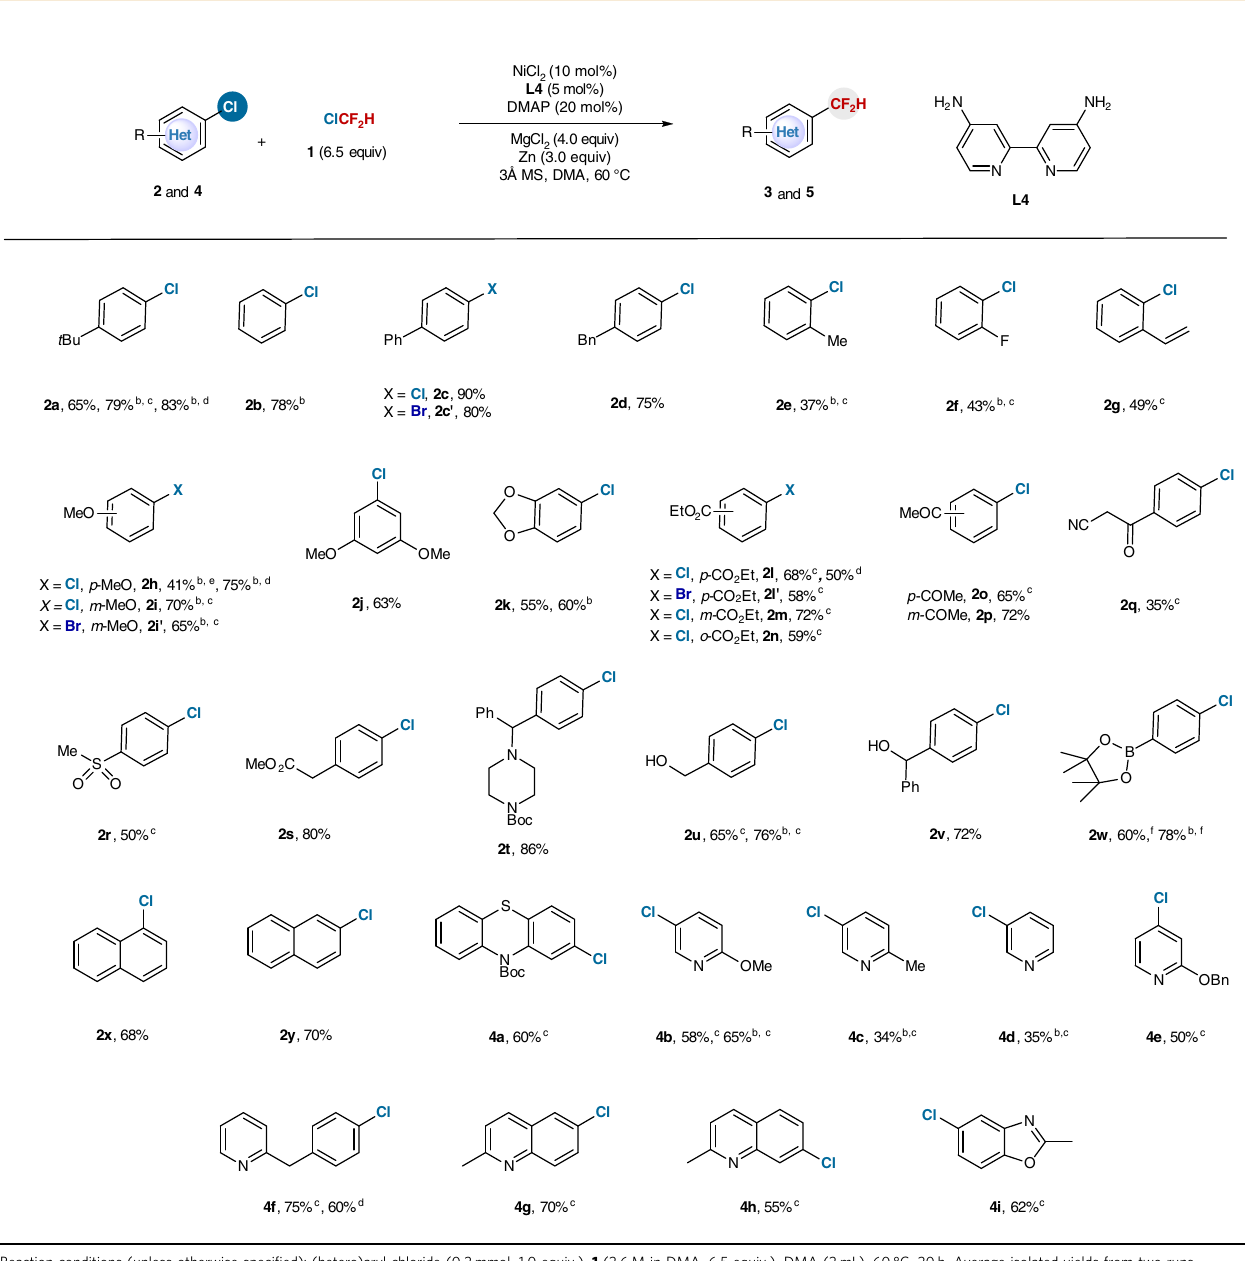
Table 2 Scope of the nickel-catalyzed reductive cross-coupling of ClCF 2 H with aryl chlorides